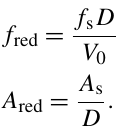
been defined. The first two are required to characterize the surge motion and have been called the surge reduced fre- quency ( f red ) and the surge reduced amplitude ( A red ), respec- tively. They are defined